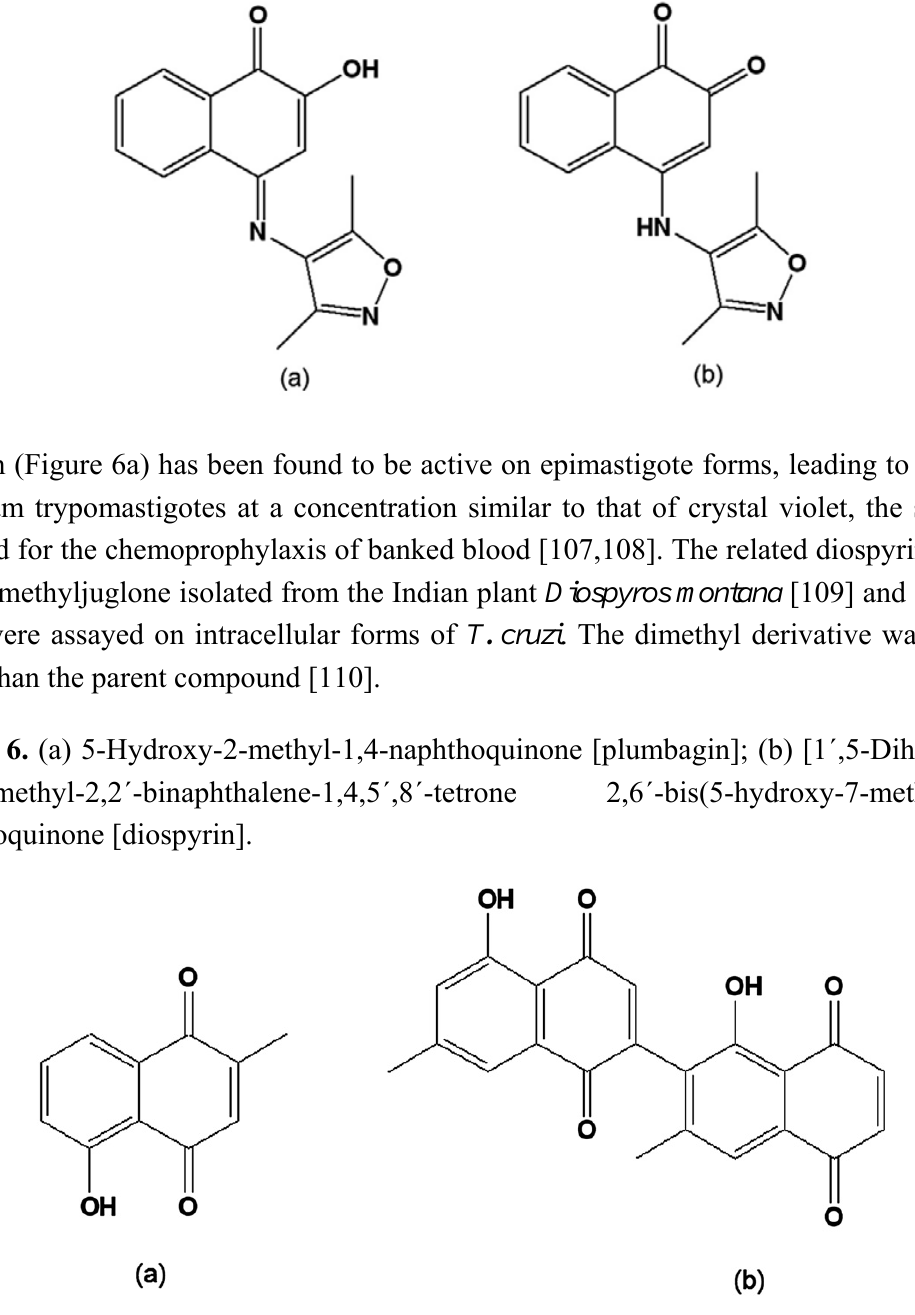
Figure 5. (a) ( E )-4-(3,5-Dimehtylisoxazol-4-ylimino)-2-hydroxynapththalene-1(4 H )-one;